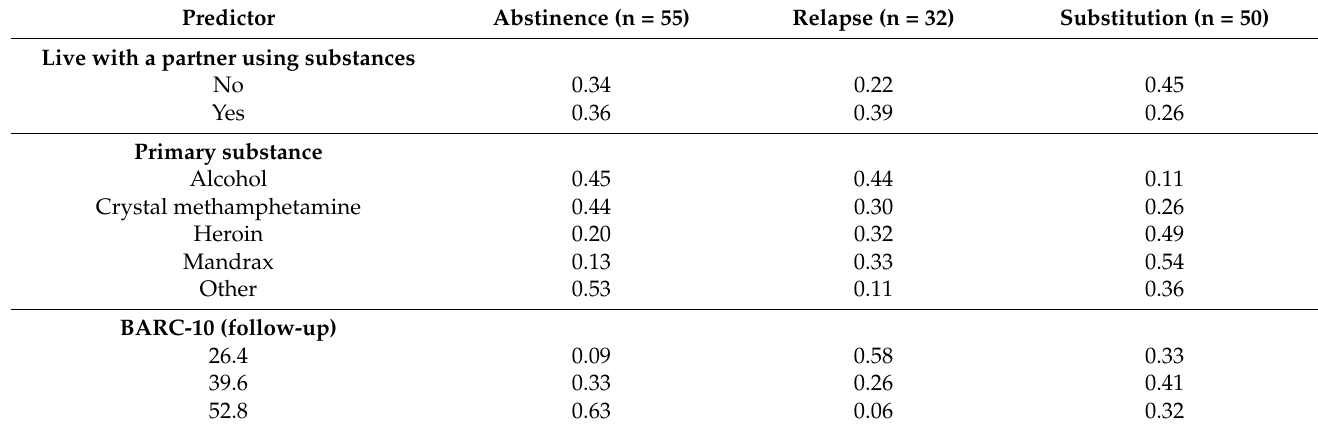
Table 3. Predicted membership probability for abstinence, relapse and